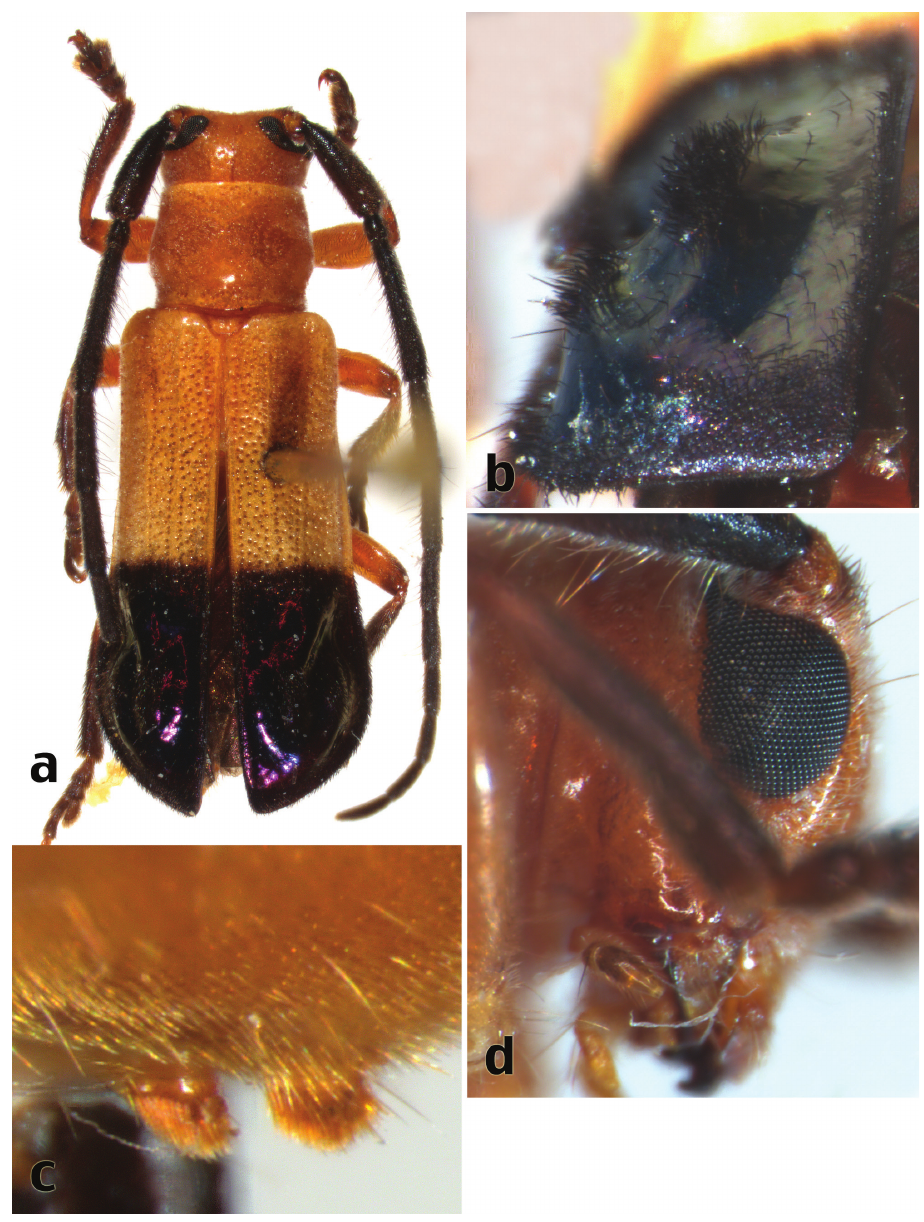
Figure 6. Calocosmus thonalmus Lingafelter, sp. n., holotype: a dorsal habitus b elytral apex c metaster- nal pubescent tufts d lateral view of